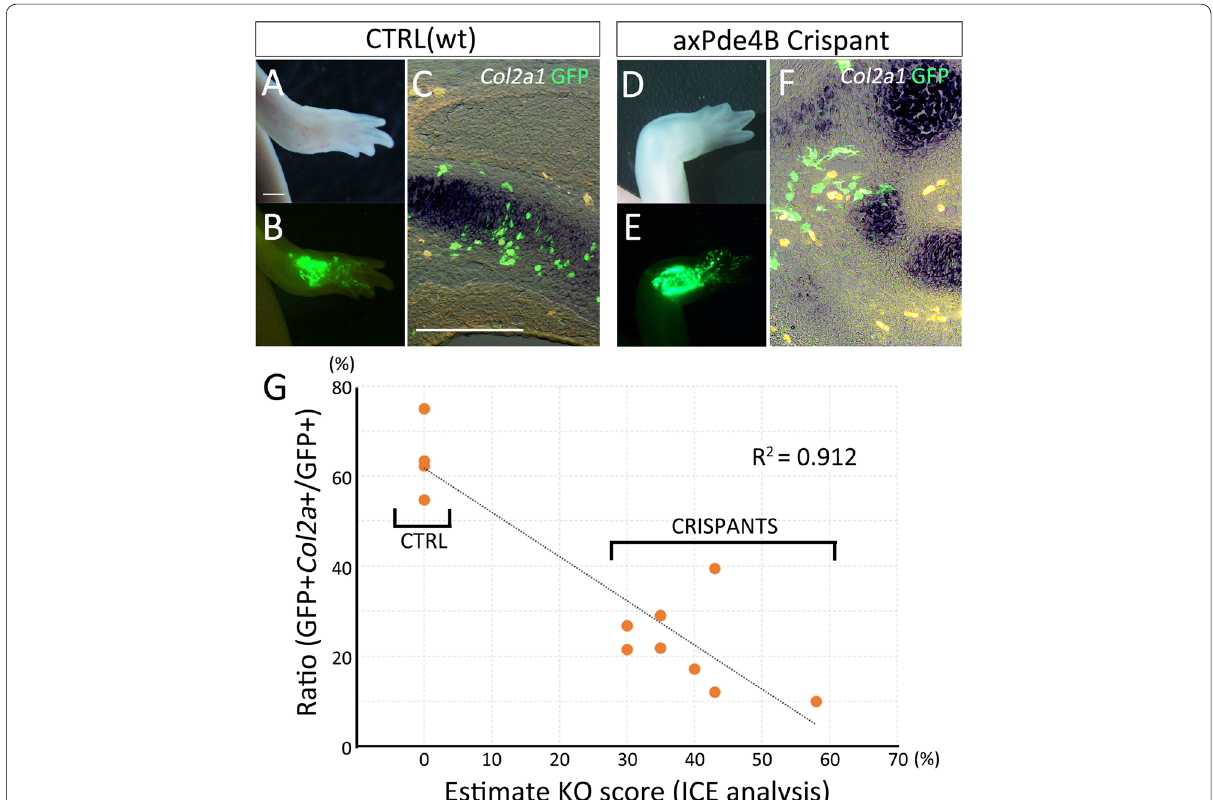
Fig. 9 Transdifferentiation from the dermis to cartilage in the mosaic Pde4b crispants. A–C the control animals (wt: wild-type). D–E The mosaic Pde4b crispants. A, D limb morphology. B, E The distribution of the GFP + cells. GFP plasmids were electroporated in the dermal region prior to amputation. C, F the merged images of the Col2a1 , GFP, and the bright field view. Col2a1 and GFP were visualized by in situ hybridization and immunofluorescence, respectively. The scale bars in A and C are 1 mm and 300 μm, respectively. G the plot of the GFP with the KO score calculated by ICE